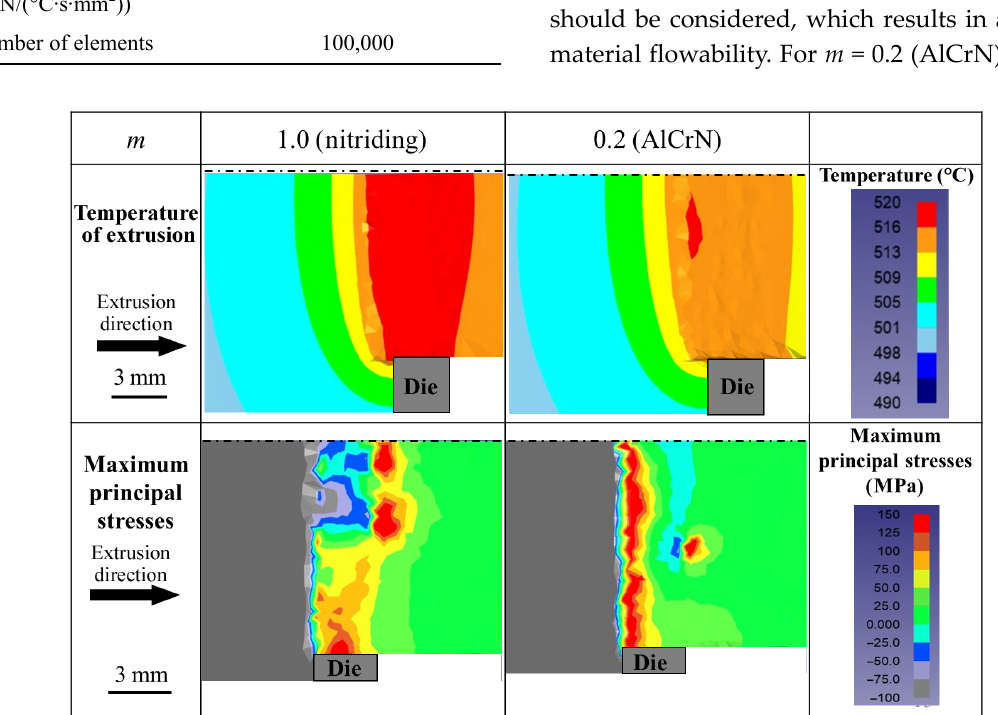
Fig. 15 Temperature distribution and principal stress distribution by hot extrusion analysis (billet temperature: 500 °C, ram speed: 0.5